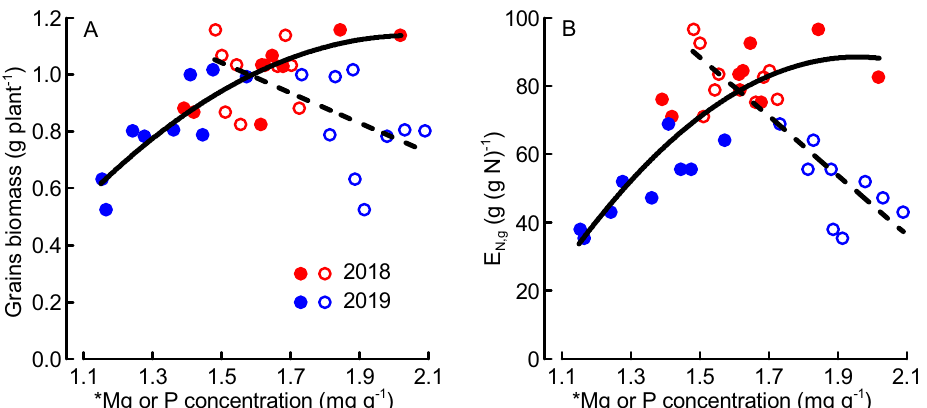
Figure 6. Grains biomass ( A ) and grain-specific nitrogen efficiency (E N,g ) ( B ) as functions of the shoot magnesium (Mg, closed symbols) or phosphorus (P, open symbols) concentrations for nine wheat varieties field-grown in Sweden during two years (2018, 2019). * indicates that Mg or P concentrations were based on data from tillering (BBCH29) and flowering (BBCH65) 35 . Regressions: y = − 0.637x 2 + 2.617x − 1.55, N = 18, R 2 = 0.80, P < 0.001 ( A, solid line for Mg ); y = − 0.528x + 1.834, N = 18, R 2 = 0.34, P = 0.011 ( A, broken line for P ); y = − 84.08x 2 + 329.08x − 233.51, N = 18, R 2 = 0.79, P < 0.001 ( B, solid line for Mg ); y = − 86.41x + 218.03, N = 18, R 2 = 0.76, P < 0.001 ( B, broken line for P ). Dots represent means from 4